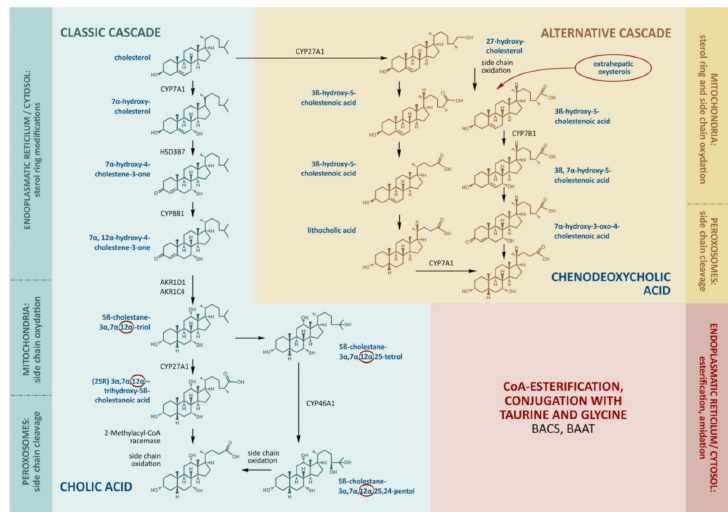
Figure 1. The main stages of cholesterol transformation and the production of bile acids. The key enzymes that determine the rate of bile acid formation include CYP7A1 and CYP8B1 in the classical cascade. CYP27A1 catalyzes side-chain oxidation in the classical cascade and initiates the alternative cascade. Cholic acid, chenodeoxycholic acid, and deoxycholic acid enter the bloodstream through the portal vein, inhibit CYP7A1, CYP8B1, and CYP27A1, and stimulate the enzymes for the conjugation of bile acids by BACS (bile acid–CoA synthase) and BAAT (bile acid–CoA:amino acid N